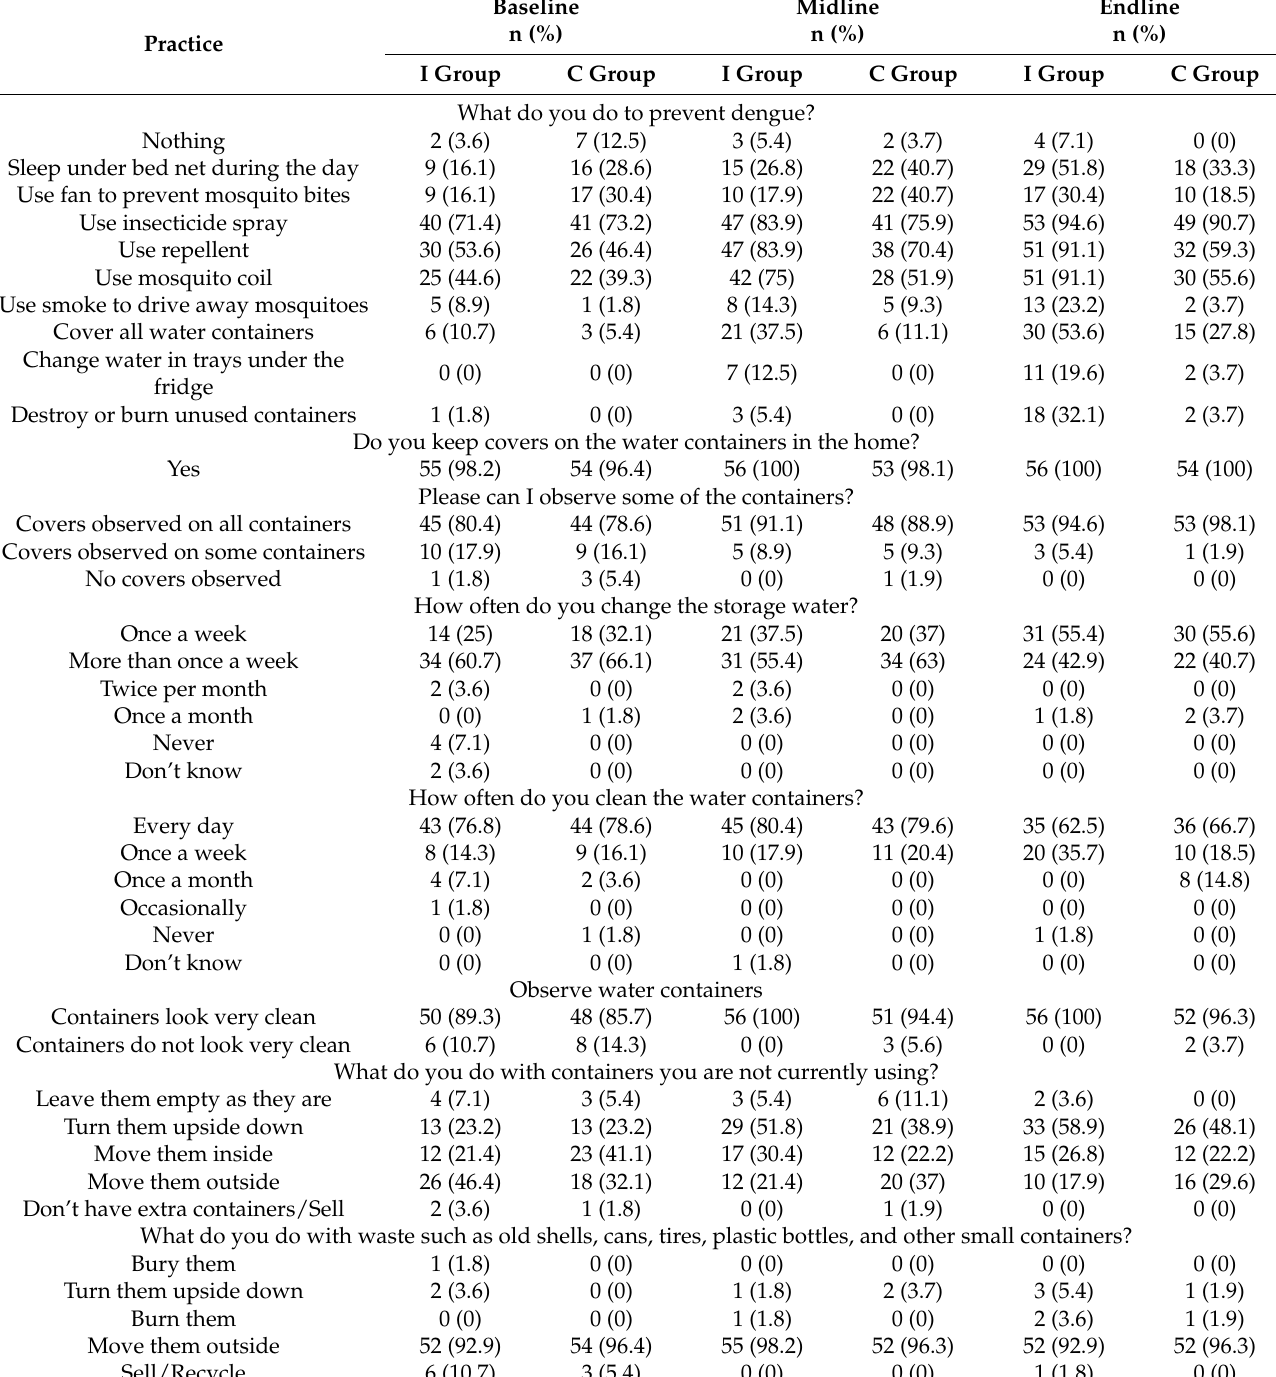
Table 6. Dengue practice at the baseline, midline, and